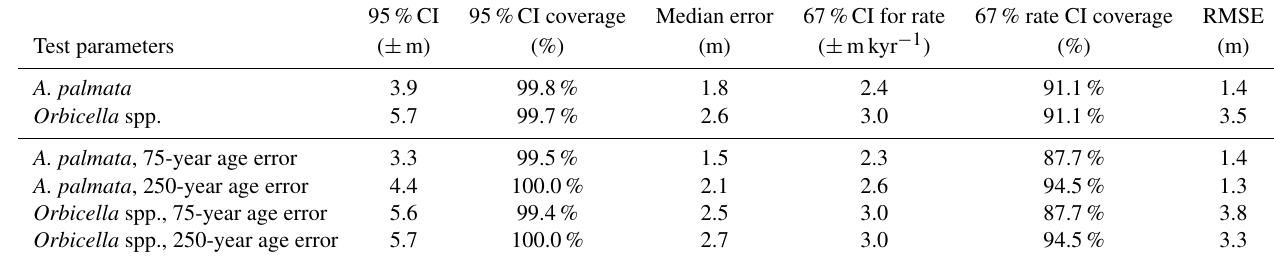
Table D3. Summary of validation test results for the Gaussian model, which are compared to the nonparametric model results (Table D5, select test parameters) with same exact data for sea-level scenario 1 (SL1) to determine the portion of improvement from more precise empirical distributions versus the inclusion of more data in the nonparametric model. See Fig. 7 for a visual representation of the